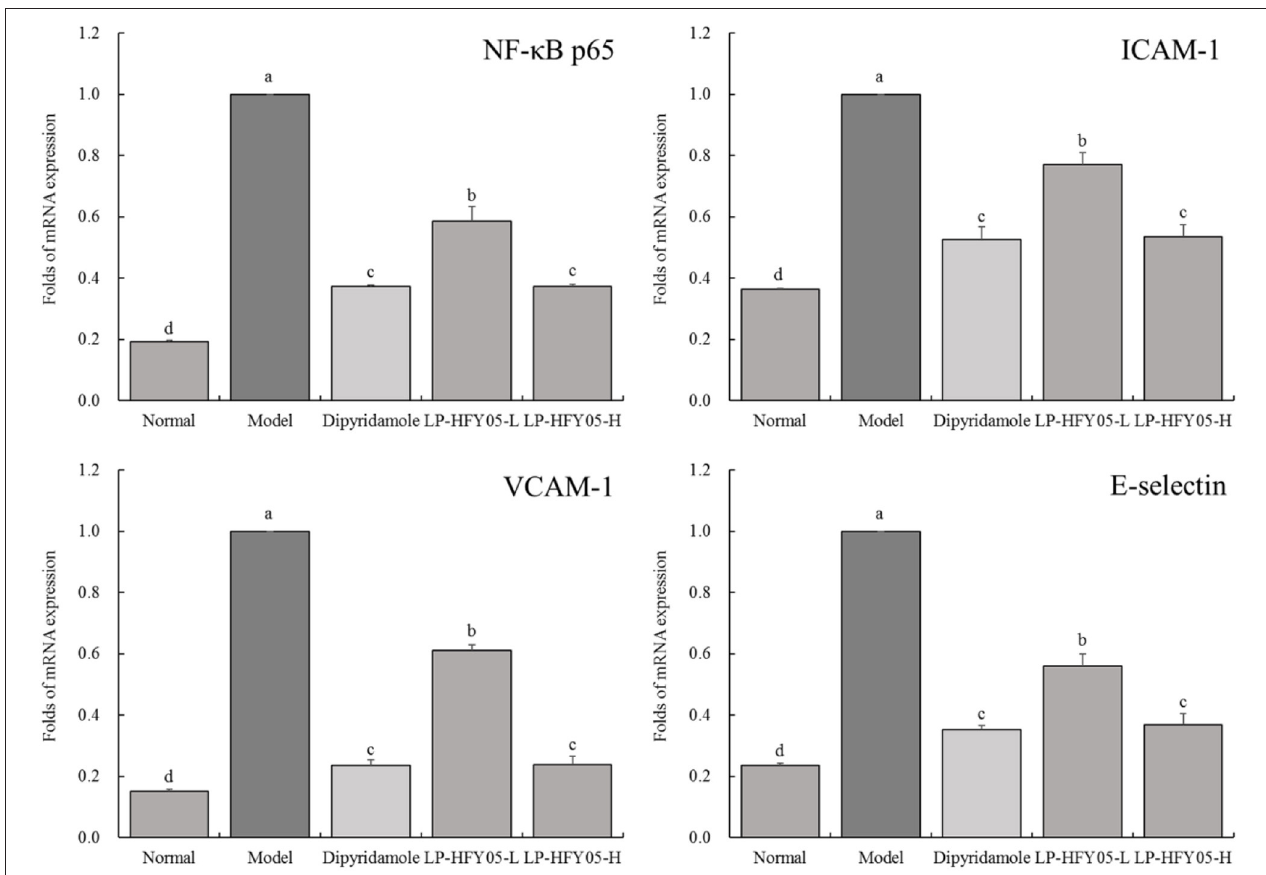
FIGURE 7 | mRNA expression of NF- κ B p65, ICAM-1, VCAM-1, and E-selectin in tail vein tissues of mice with thrombosis. a − d Mean values with different letters in the different bars were significantly different ( P < 0.05) according to the SNK multiple-range test; b, c, and d indicate significance vs the model group; the same letter of c indicates that there was no significant difference ( P > 0.05) between the two